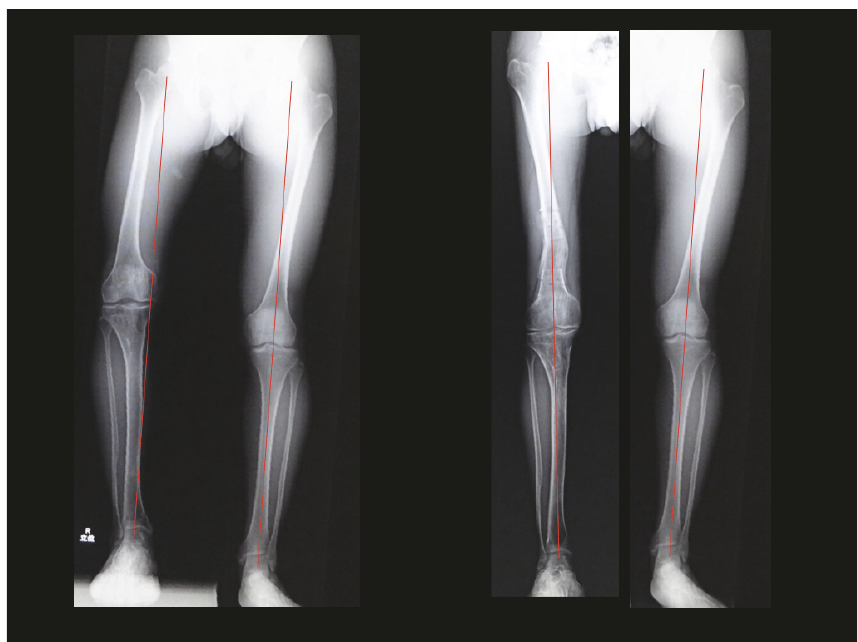
Figure 5: Correction of extra-articular deformity by using hexapod external fixator system. X-ray photos (a) before and (b) after